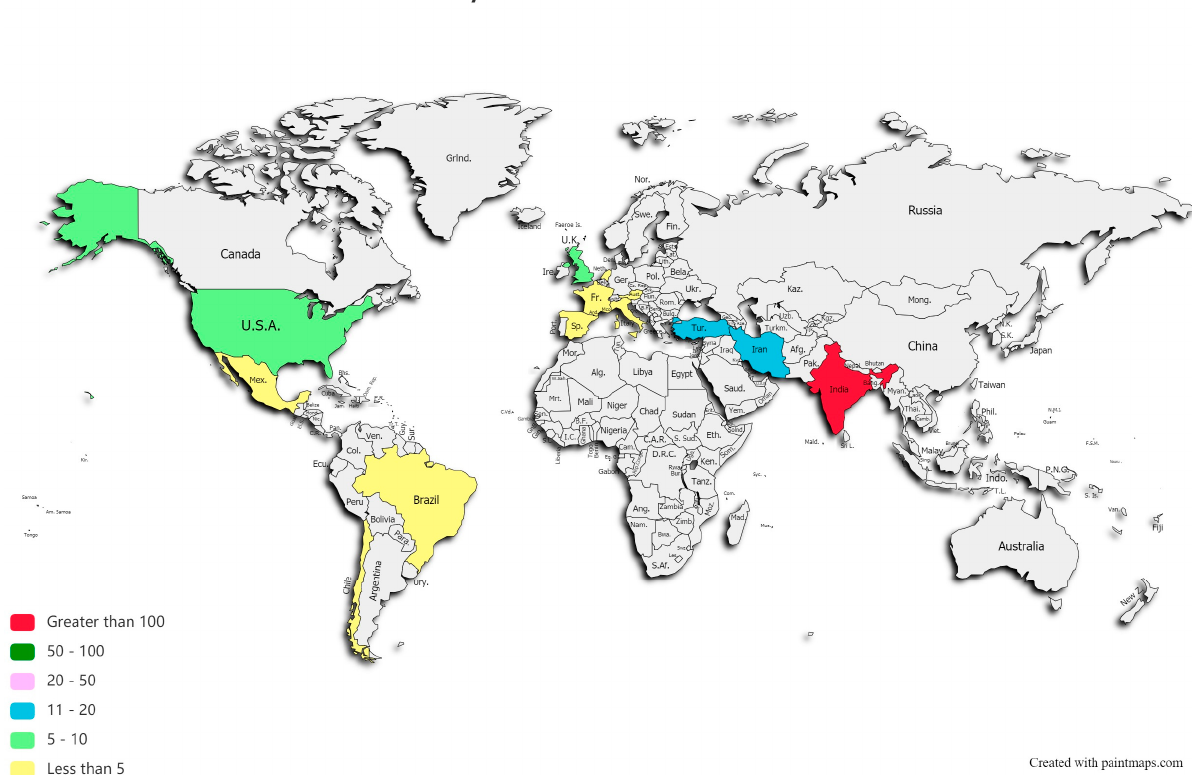
Figure 2. Global distribution of COVID-19 associated mucormycosis .